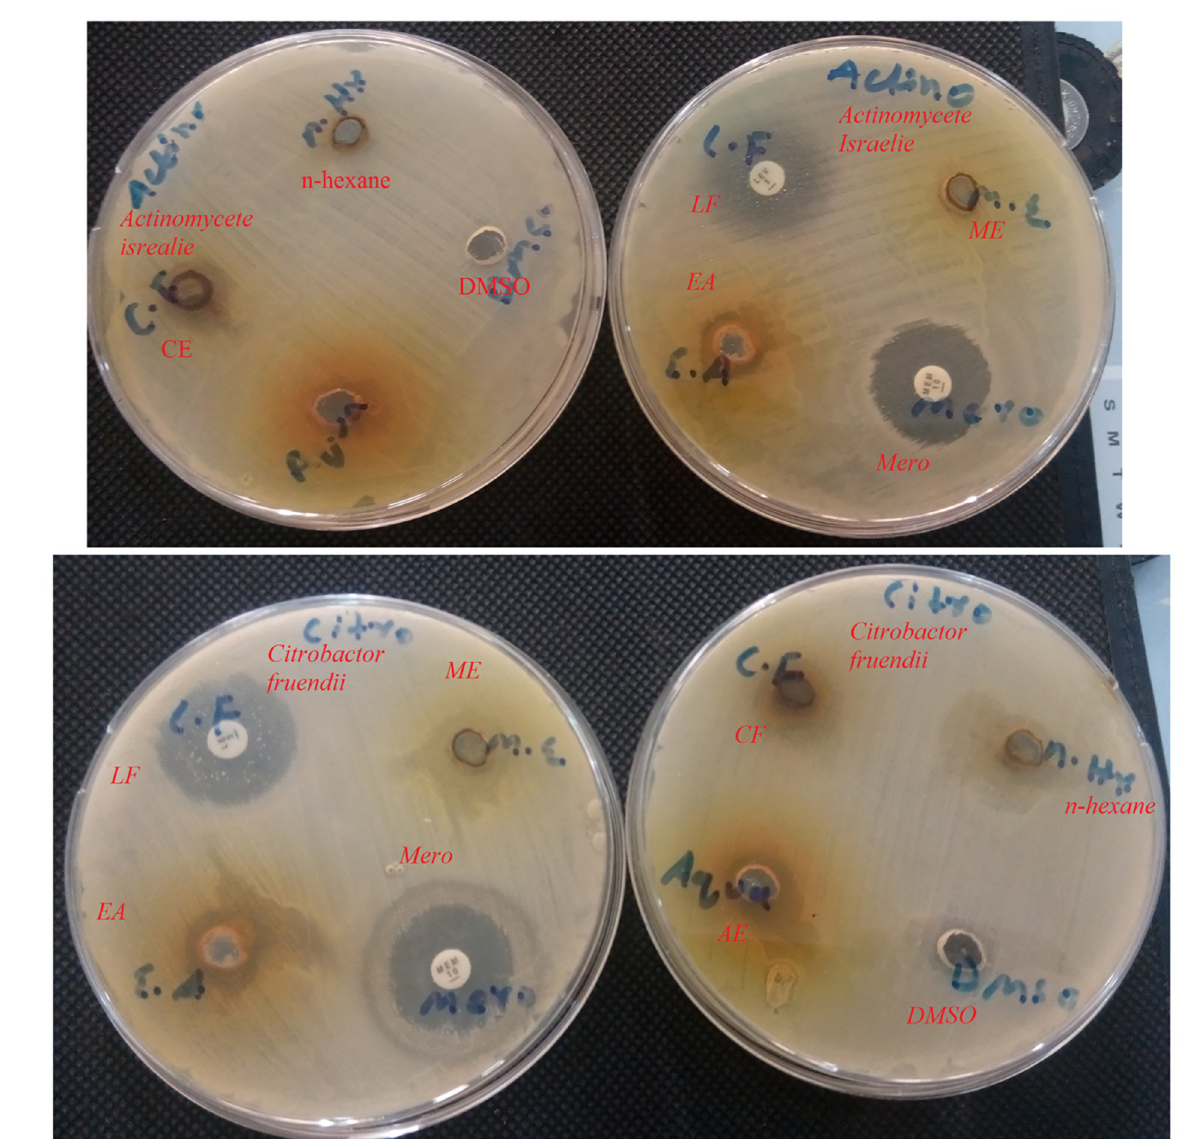
Fig 1. Zone of inhibition of extract against specific bacteria. Aqua: Aqueous Sub-fraction: C.F: Chloroform Sub-fraction; DMSO: Dimethyl Sulfoxide Sub-fraction; E.A: Ethyl Acetate Sub-fraction; L.F: Levofloxacin; M.E: Methanolic Extract; MERO: Meropenam. https://doi.org/10.1371/journal.pone.0280127.g001 Tail-immersion test in mice . In the tail immersion test all fractions displayed analgesic activ- ity. However, chloroform and n-hexane showed maximum inhibition followed by ethyl ace- tate, crude and aqueous. In tail immersion test; the extracts of iris albicans showed numerically significant dose dependent activity i.e. 300 mg > 200 mg > 100 mg. It was also observed that lipid soluble extracts showed better activity as compared to the low lipid soluble extracts. At 300 mg/kg dose, all the extracts possessed excellent decrease in licking and jumping response in mice while 200 mg dose of all extracts except chloroform and n-hexane fractions; showed moderate effects. However; all extracts (100, 200 and 300 mg/Kg body weight) significantly increase latency period as shown in Table 6.